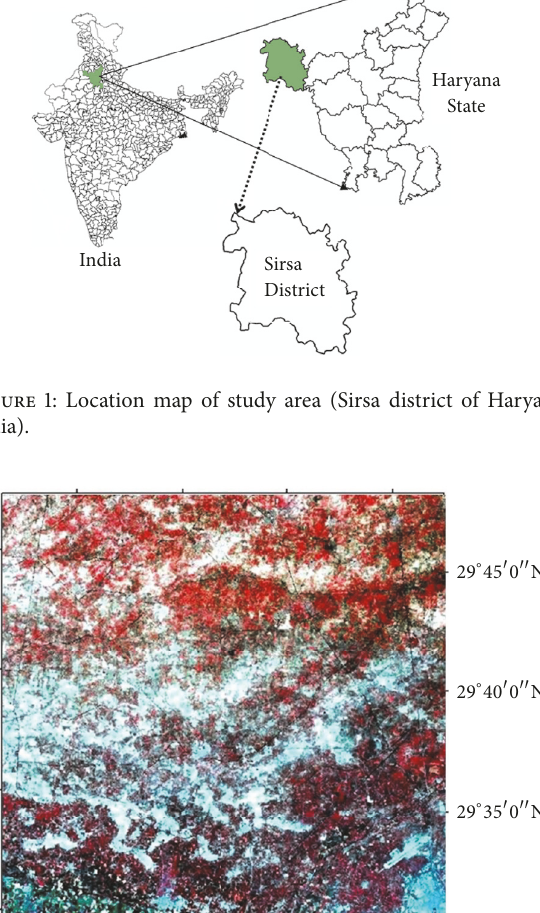
Table 1: Accuracy assessment